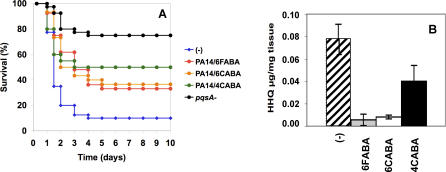
The AA Analogs Promote Survival of B+I Mice to PA14 Pathogenesis, and Restrict In Vivo HHQ Production(A) PA14-infected mice were injected 6 h post-B+I with 6FABA, 6CABA, or 4CABA. Mice infected with pqsA− cells served as an additional control group. Data were averaged for a minimum of two independent experiments, with n(PA14) = 40; n(PA14/6FABA) = 36; n(PA14/6CABA) = 30; n(PA14/4CABA) = 20 and n(pqsA−) = 20. Standard deviations were <20% for the time points between 0 and 4 d, and <12% thereafter. Cox proportional hazards regression showed that mouse mortality due to PA14 infection was significantly reduced by injection with 6FABA (hazard ratio = 0.398, p = 5.6e-04), 6CABA (hazard ratio = 0.397, p = 1.2e-03), and 4CABA (hazard ratio = 0.325, P = 1.8e-03), compared with control saline; pqsA− virulence was highly attenuated (hazard ratio = 0.118, p = 9.1e-06).(B) HHQ levels (μg/mg) at 12 h post-B+I for rectus adbominus muscle directly underlying the infection site in untreated B+I mice, and for mice treated 6 h post-B+I with 6FABA, 6CABA, or 4CABA. n = 5 for each experimental condition. The t-test (p = 0.011) and Wilcoxon rank sum test (p = 0.03) showed that the difference in HHQ levels between control and 4CABA-treated mice was statistically significant.